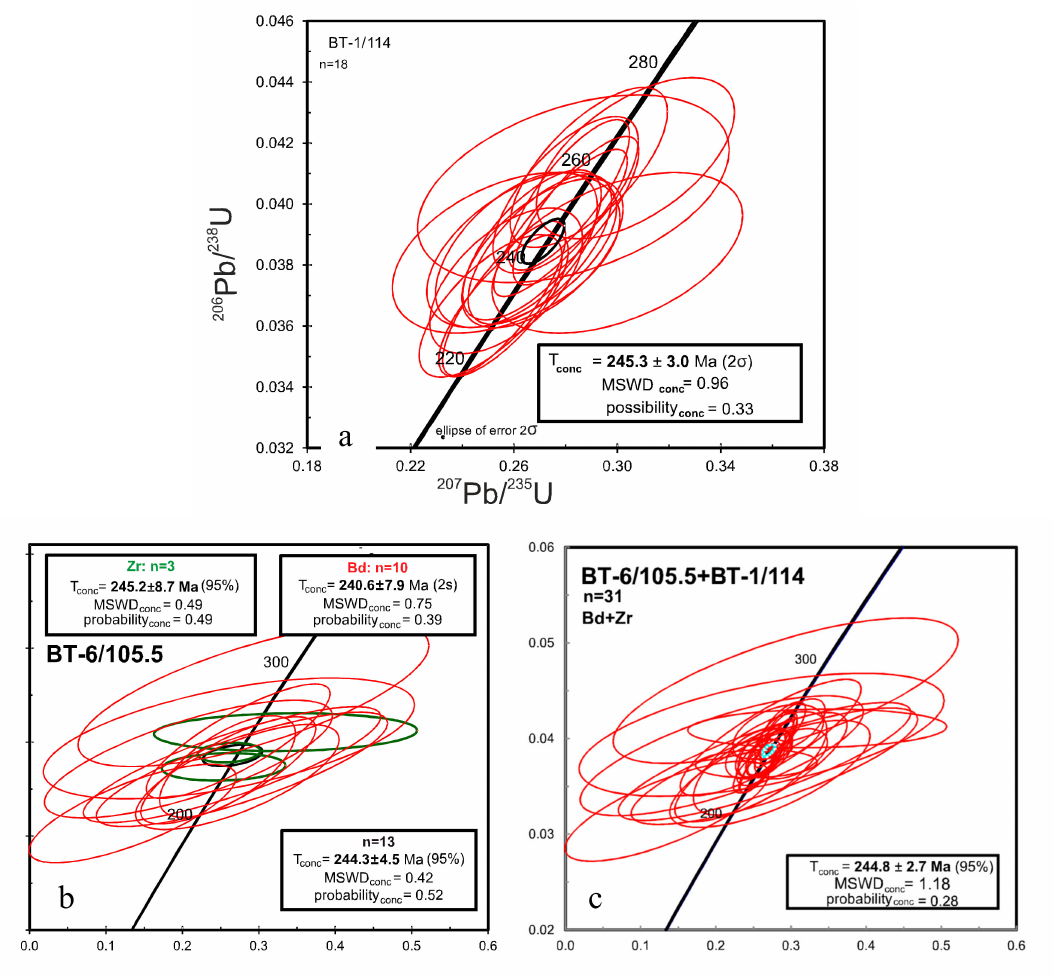
Figure 11. The U–Pb diagrams with Concordia for baddeleyite (red) and zircon (green) from trachydolerites of samples BT-1 / 114.6 ( a ) and BT-6 / 105.5 ( b ) and for a total of 31 concordant data-points from these samples ( c ). Reported ellipses correspond to a 95% level of confidence of analytical